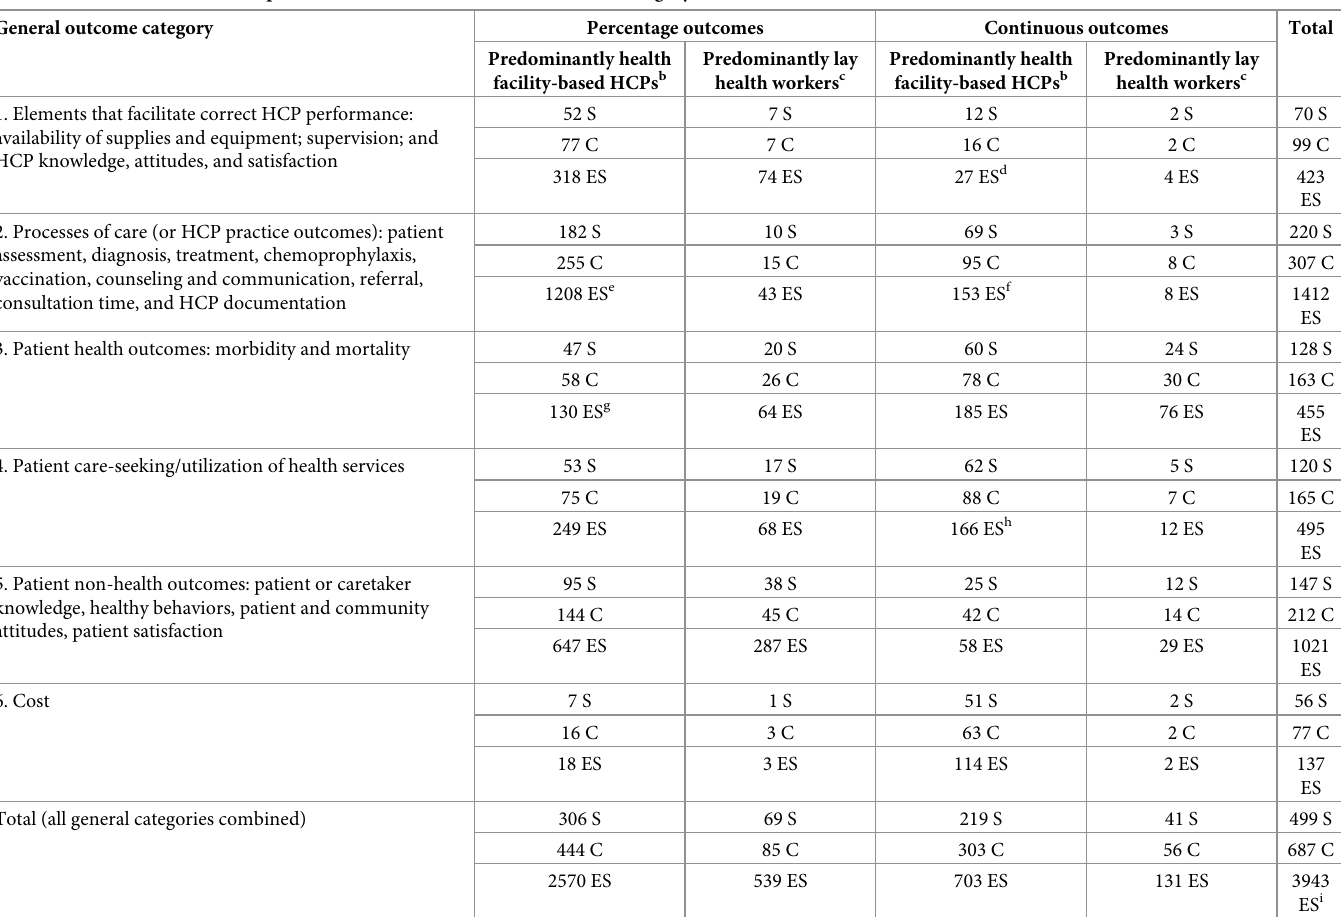
Table 1. Number of studies, comparisons, and effect sizes for each outcome category a